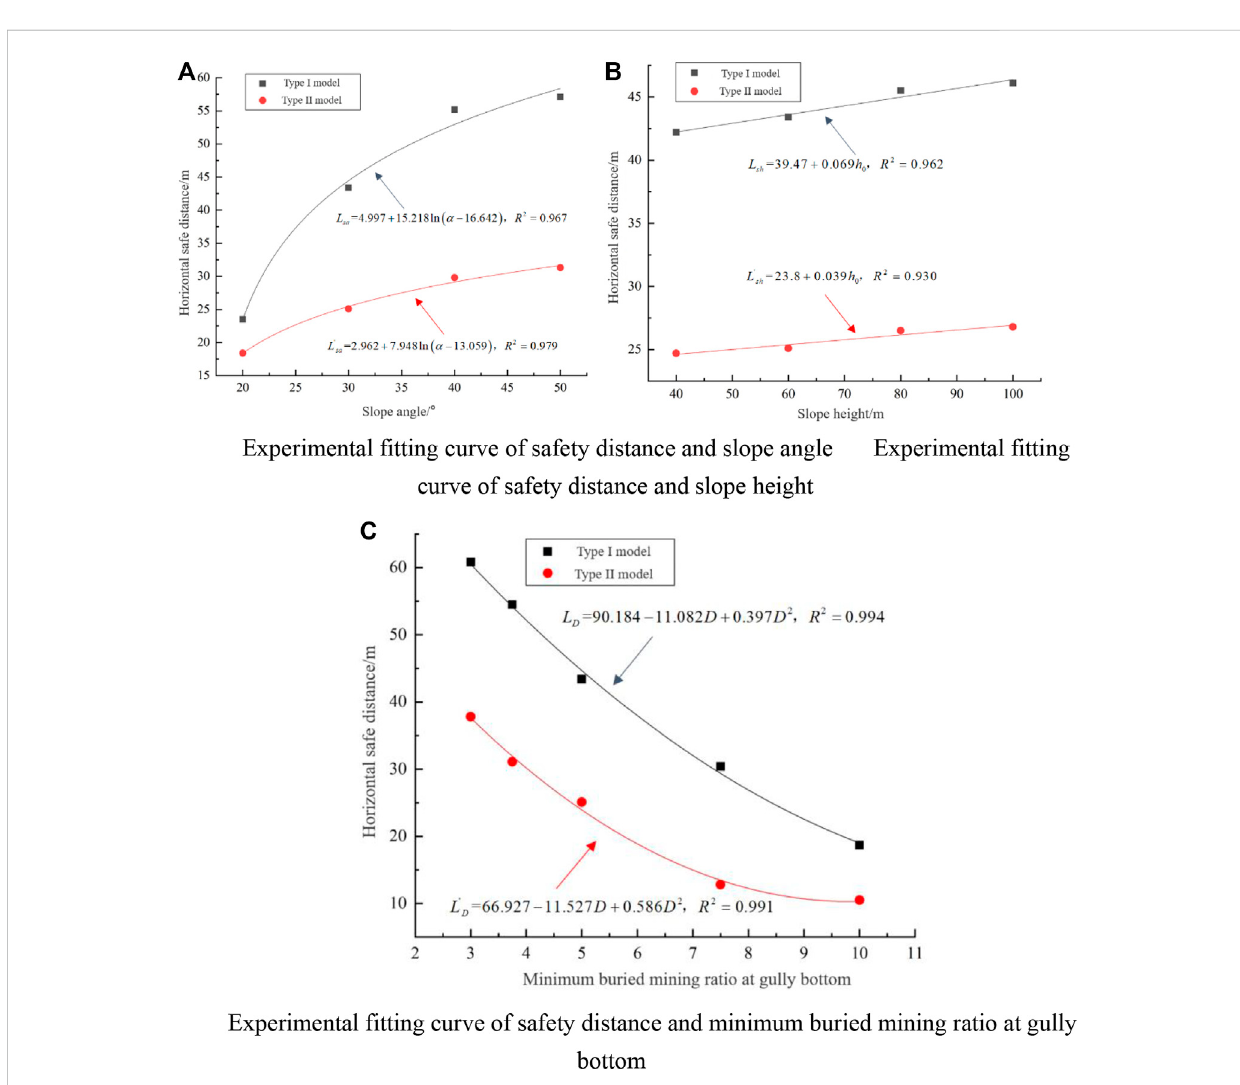
Frontiers in Earth